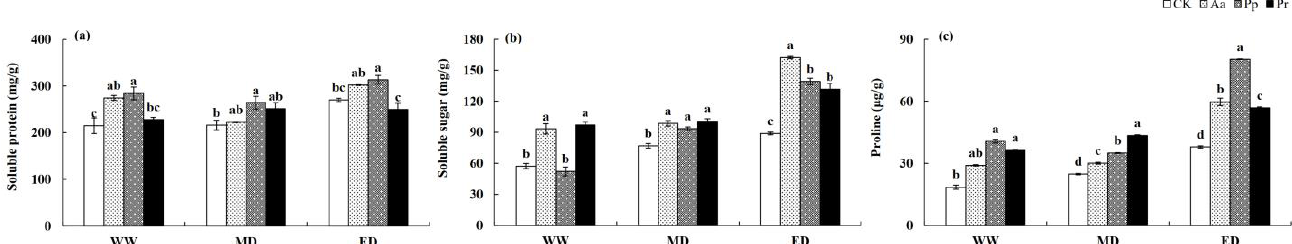
Figure 4. Influences of DSE on the contents of soluble protein and sugar and proline in wheat leaves under different water treatments. ( a ) soluble protein; ( b ) soluble sugar; ( c ) proline. WW, well-watered. Different letters under a certain water condition indicate significant differences among the four DSE treatment groups ( p < 0.05). MD, mild drought stress. ED, severe drought stress.